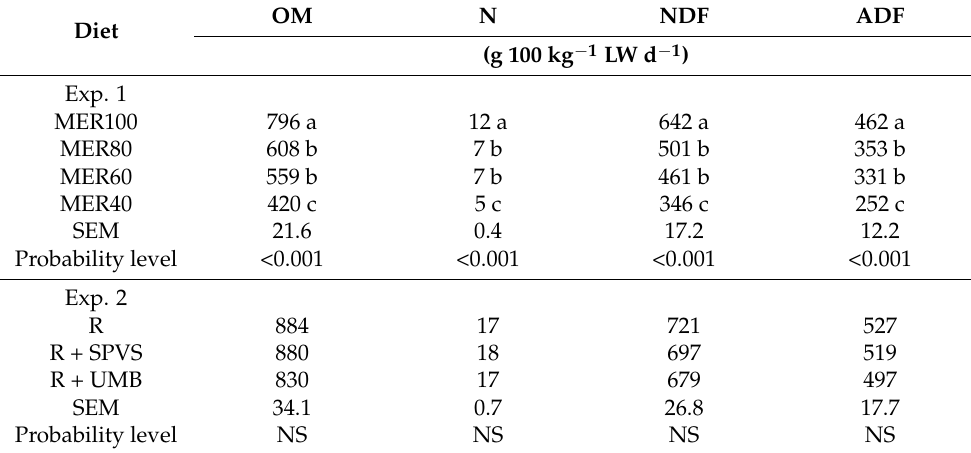
Table 4. Fecal excretion (in g per 100 kg live weight; LW) of organic matter (OM), nitrogen, neutral detergent fiber (NDF) and acid detergent fiber (ADF) by Boran steers (experiment 1) fed diets corresponding to different levels (%) of maintenance energy requirements (MER) and by Holstein × Boran heifers (experiment 2) offered roughage alone (R; wheat straw and Rhodes grass hay), or R supplemented with sweet potato vine silage (R + SPVS) and urea-molasses blocks (R + UMB); standard error of the mean (SEM); probability levels obtained with lme function.